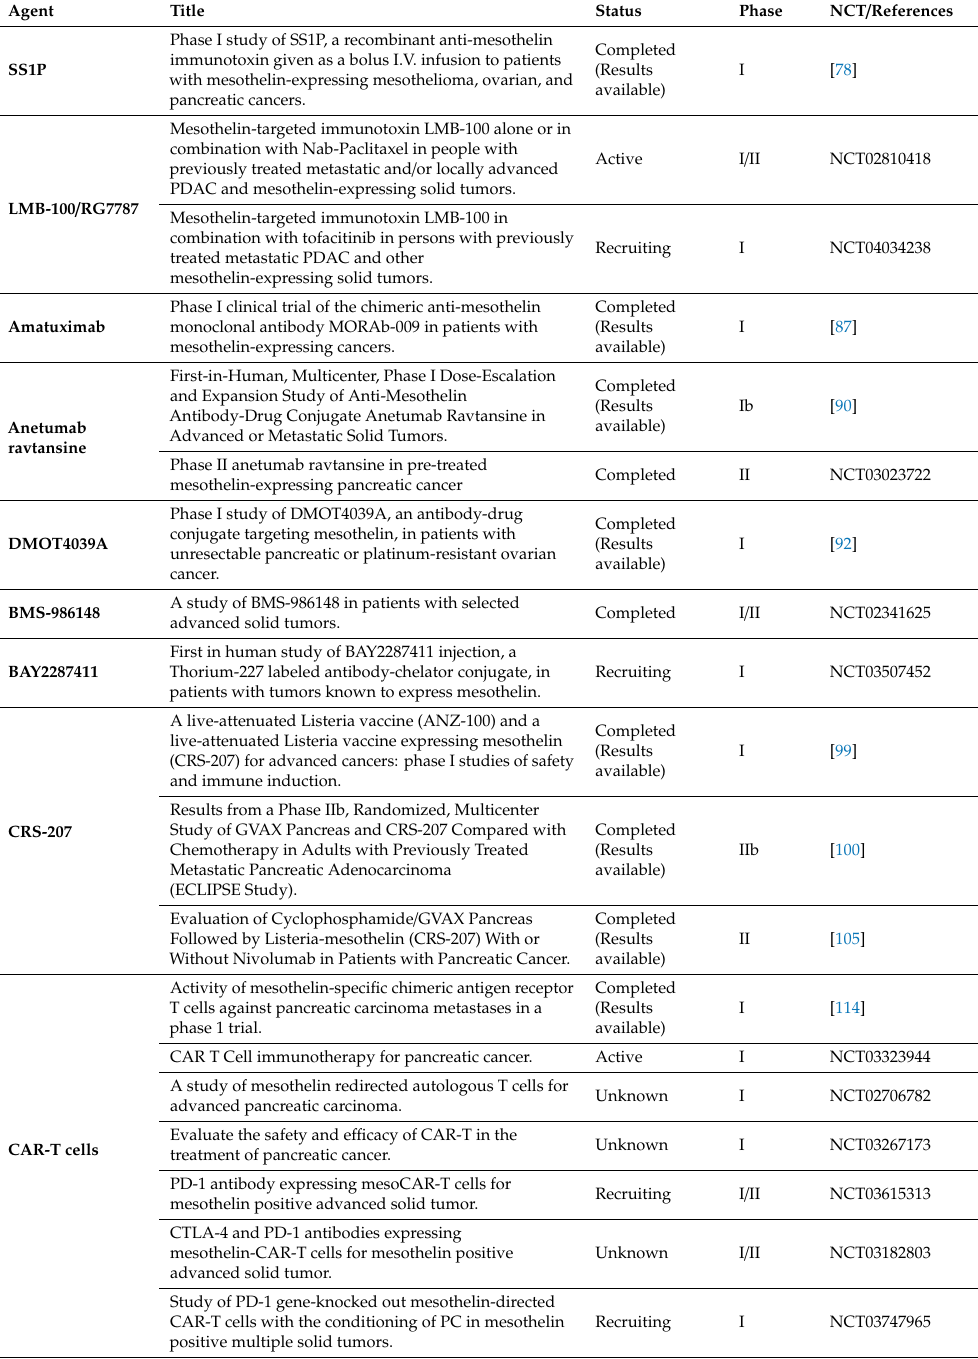
Table 1. Clinical trials for MSLN-targeted therapies in